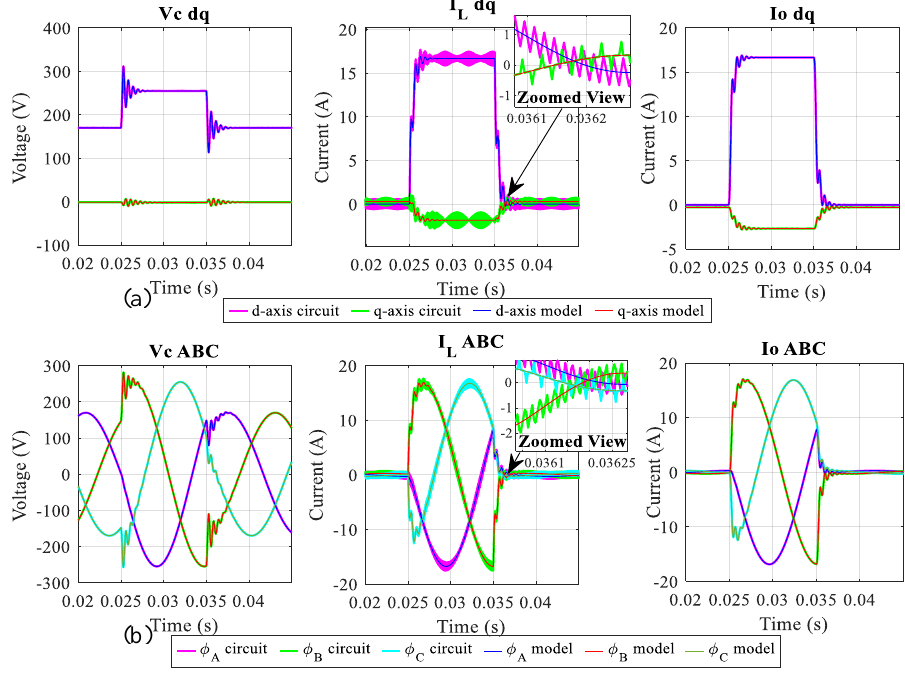
Figure 7. State-vector waveforms for the mathematical model and the circuit in grid-connected mode. ( a ) dq frame. ( b ) ABC frame.